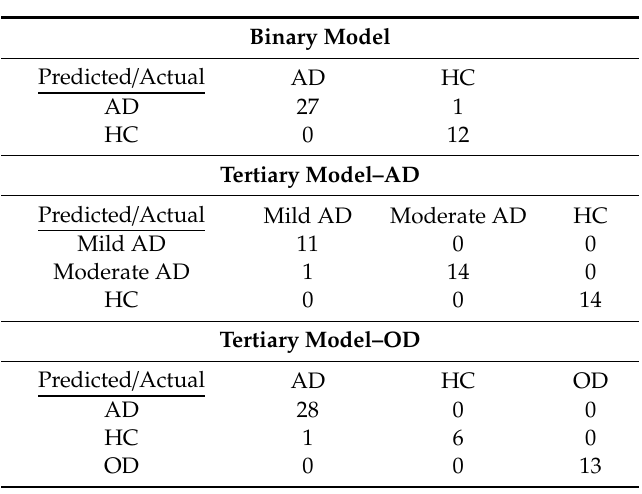
Table 4. Confusion table of the prediction results achieved for selected networks during the testing phase on the test datasets for all three models with spectra used as individual